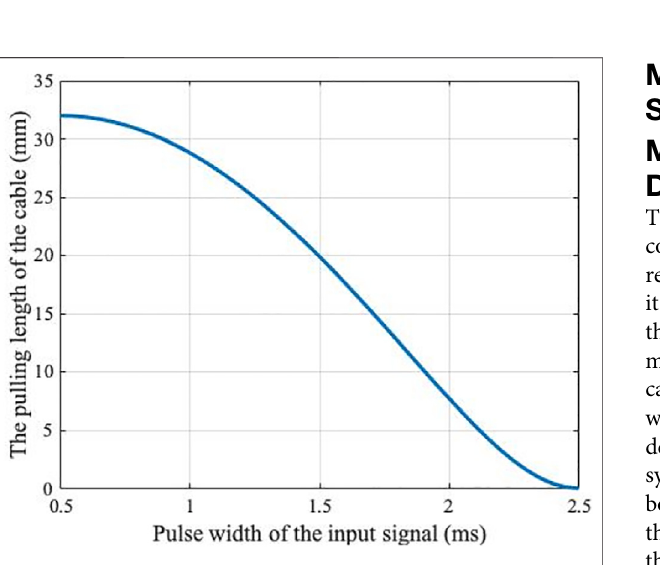
Frontiers in Robotics and AI |